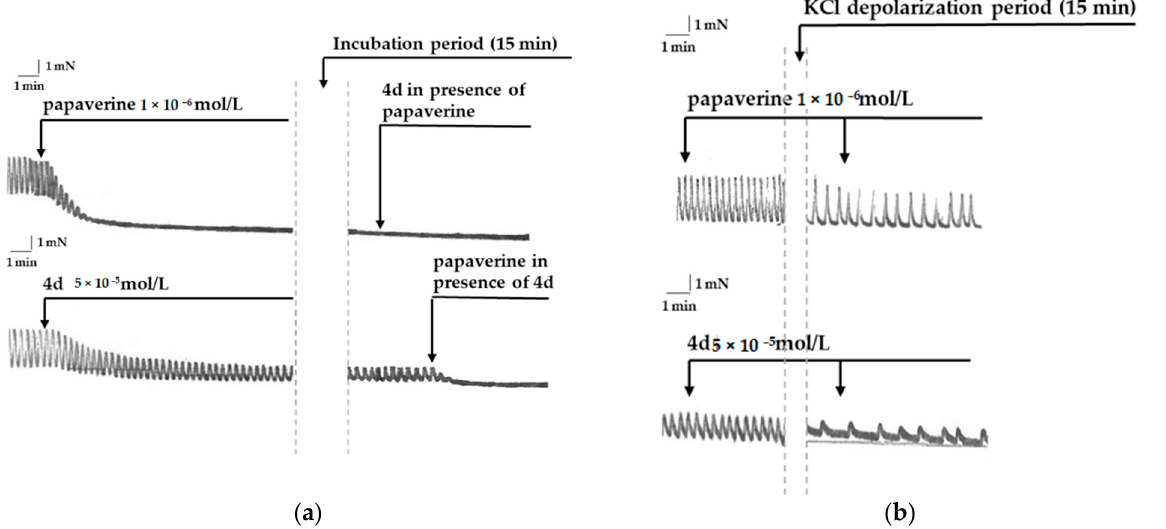
Figure 3. Representative tracings of: ( a ) corpus SMP from rat elicited by 1 × 10 − 6 mol/L papaverine and 5 × 10 − 5 mol/L 4d at single or combined administration; ( b ) SM activity parameters before and after KCl depolarization.